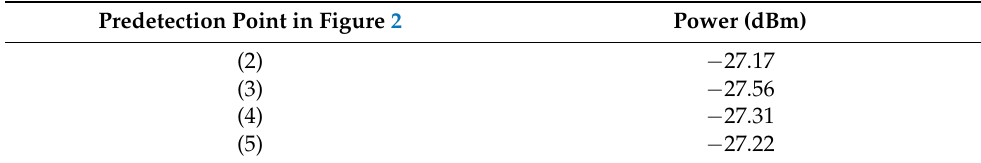
Table 5. The simulated output power at each predetection point in the schematic of Figure 2 for an